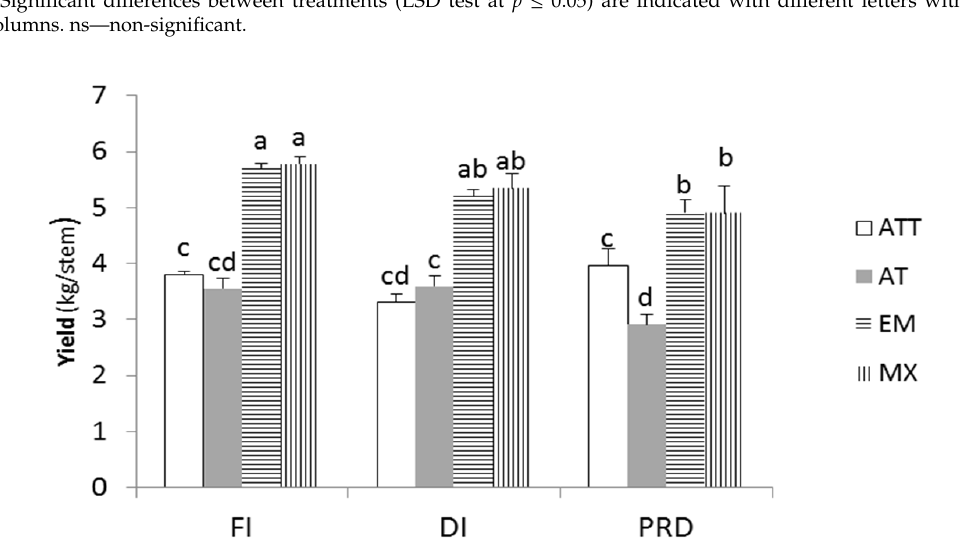
Figure 2. Total yield (kg stem − 1 ) of grafted tomato plants grown with one or two stems under three irrigation techniques. Vertical bars represent SE values ( n = 4). Di ff erent letters above column indicate a significant di ff erence by the LSD test at p < 0.05. ATT—one-stem Attiya; AT—two-stem Attiya; EM—Emperador;